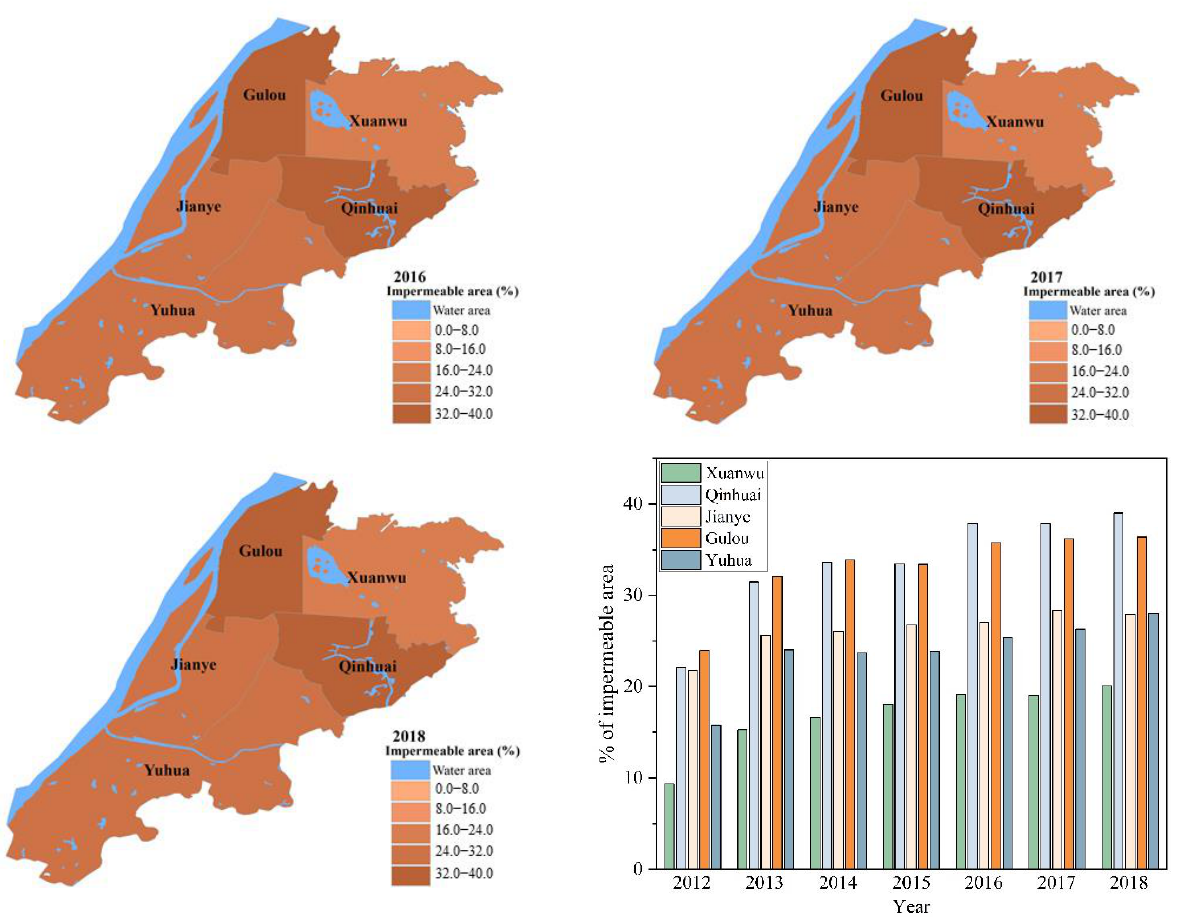
Figure 3. Spatial distribution maps of the impermeable area from 2012 to 2018 for the five districts.